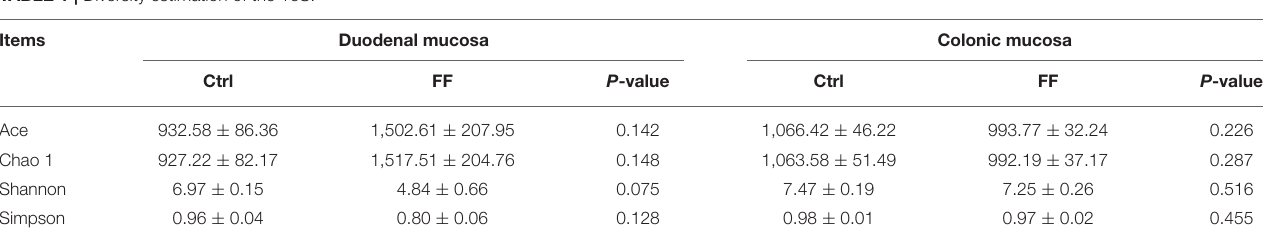
TABLE 1 | Diversity estimation of the 16S.